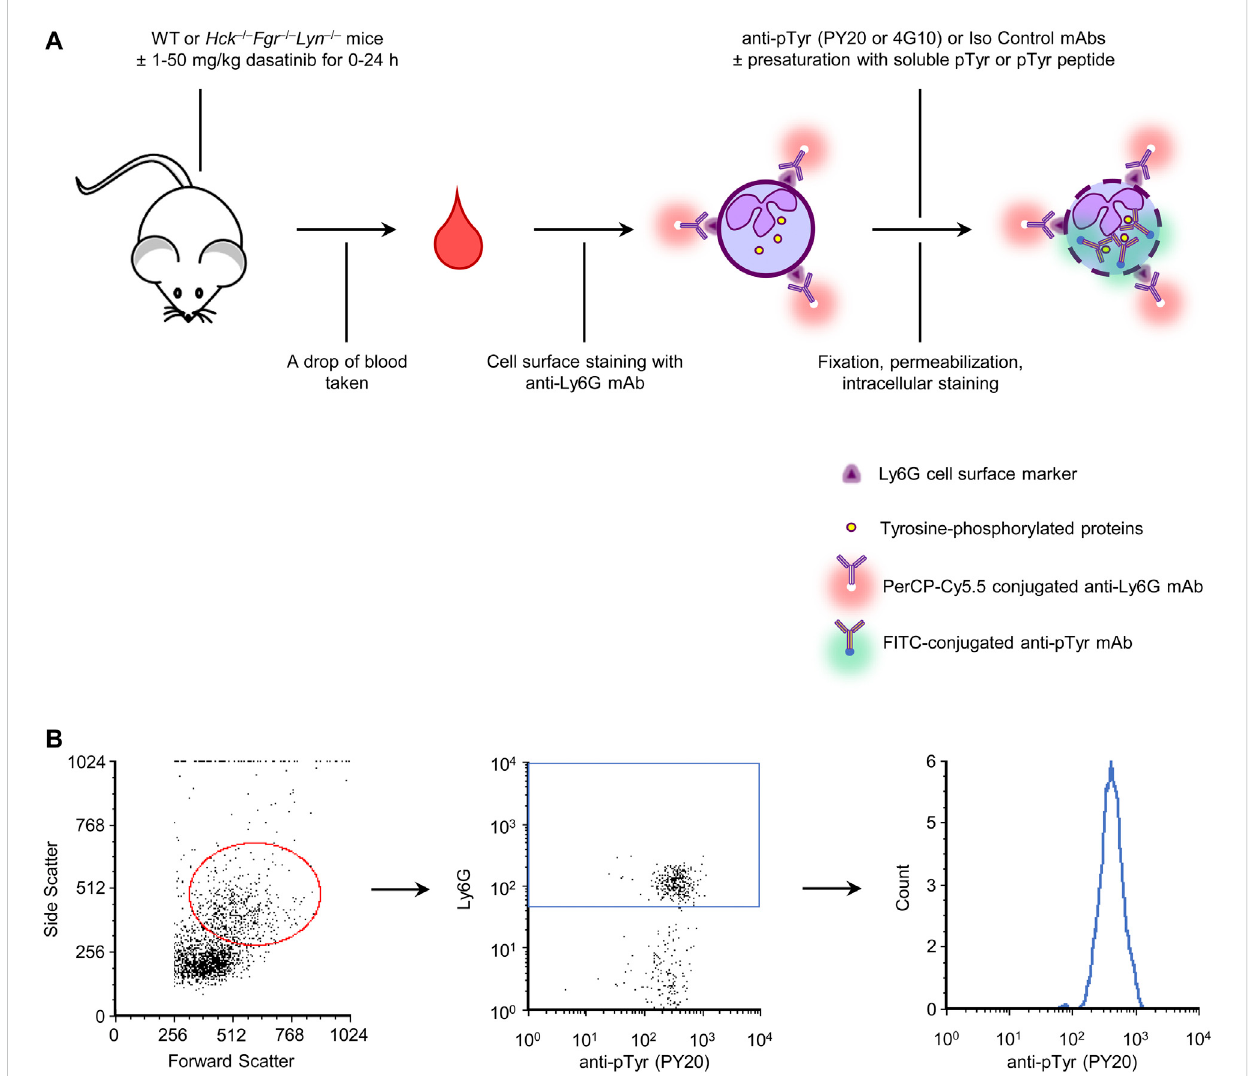
Assay overview and gating strategy. A drop of blood was stained for a neutrophil marker and for intracellular tyrosine phosphorylated proteins. A number of control and validation experiments were also performed, as indicated (A) . Neutrophils were identi fi ed based on their typical forward and side scatted characteristics and positive staining for the Ly6G neutrophil marker. Tyrosine phosphorylation within those cells was then determined by intracellular fl ow cytometry using fl uorescently labeled anti-phosphotyrosine antibodies (B) . WT, wild-type; pTyr, phosphotyrosine; mAb, monoclonal